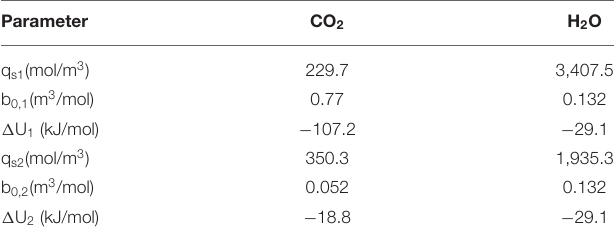
TABLE 2 | CO 2 and H 2 O adsorption isotherm parameters in the 3D printed sorbent.